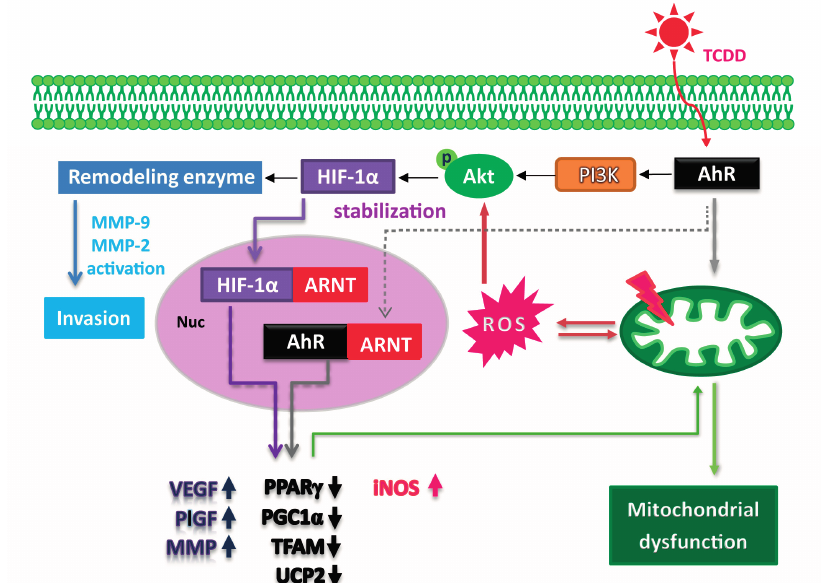
Figure 6. Schematic diagram of the TCDD induced HIF-1 α molecular signaling. TCDD induced HIF-1 α stabilization via the AhR or ROS-dependent activation of the PI3K/Akt pathway. A significant increase in invasion, MMP9 activity, and VEGF and PlGF gene expression was found in the TCDD-treated cells. Furthermore, down regulation of metabolic regulators PPAR γ and PGC-1 α was involved in the TCDD-induced insults. TFAM and UCP2, downstream targets of PGC1 α , were concurrently suppressed and may lead to mitochondrial dysfunction. Taken together, our results indicate that an activated HIF-1 α pathway, elicited oxidative stress, and induced metabolic stress contribute to TCDD-induced trophoblastic